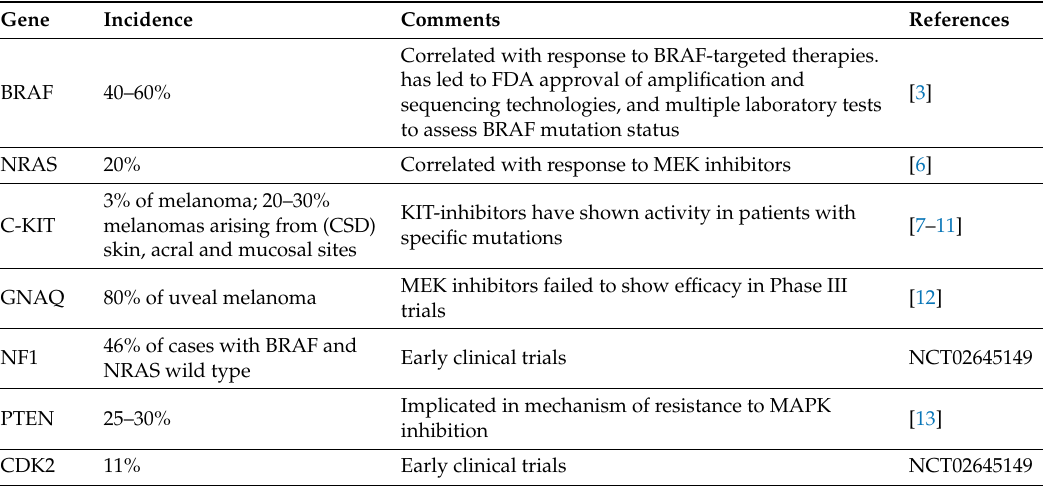
Table 1. Selected Biomarkers in Melanoma-Targeted